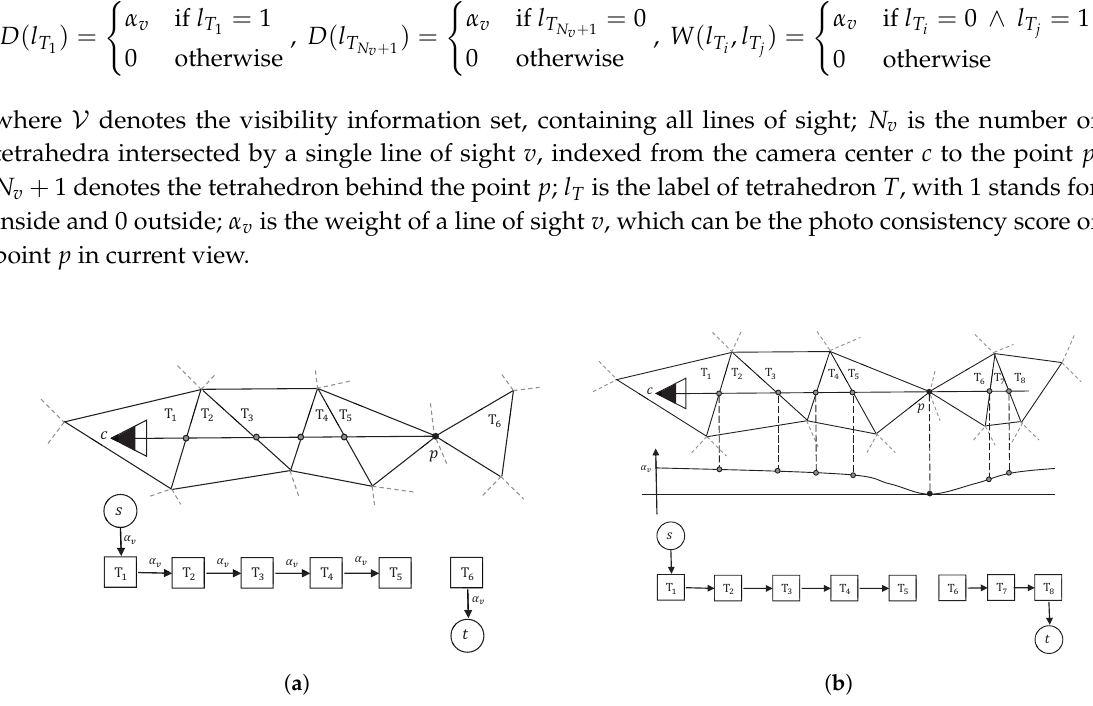
Figure 3. Typical visibility model and soft visibility model in 2D. ( a ) Typical visibility model; and ( b ) soft visibility model for a single line of sight v ; how to assign weight (energy) to the tetrahedron containing camera center, the end tetrahedron and the facets intersected by ( c , p ) or its extension are